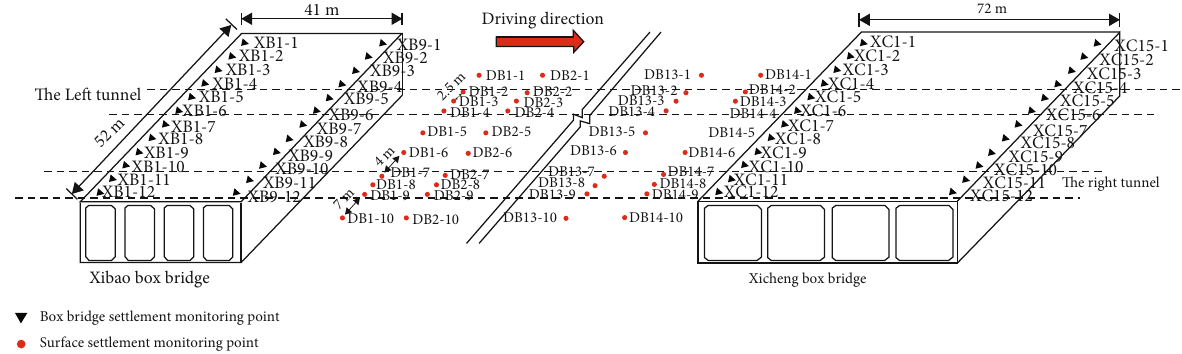
Figure 11: Plane layout of the settlement monitoring points of the ground surface and the box bridges.